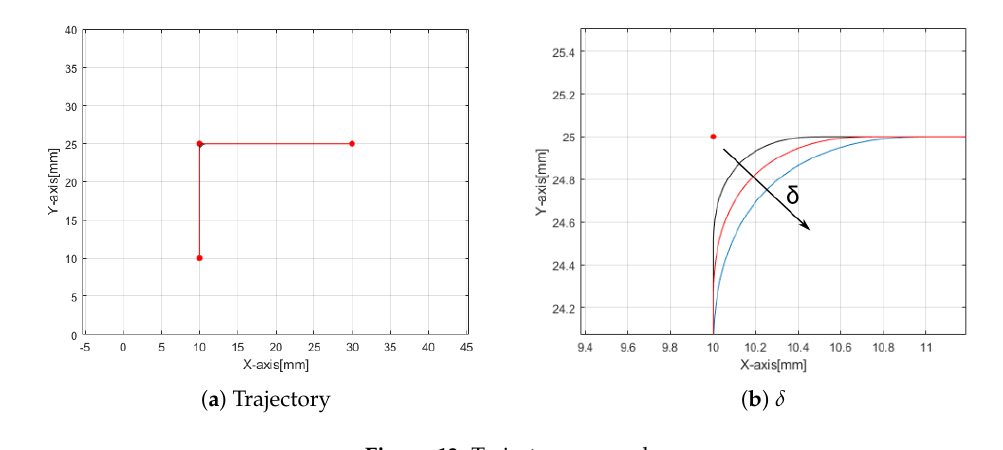
Figure 13. Trajectory